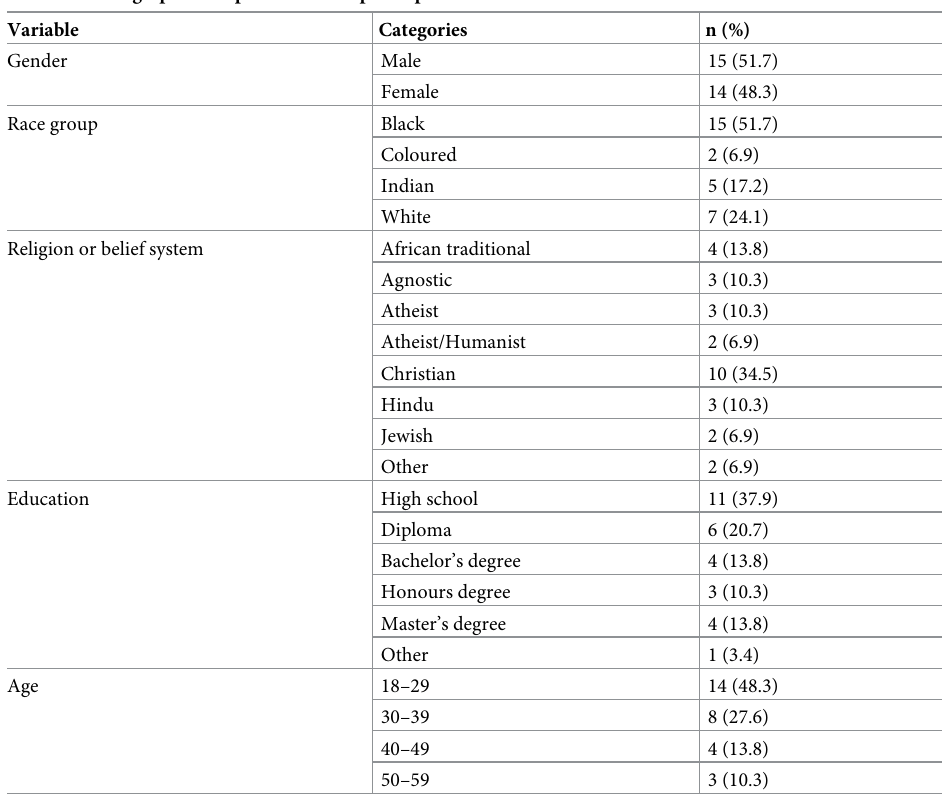
Table 1. Demographic composition of the